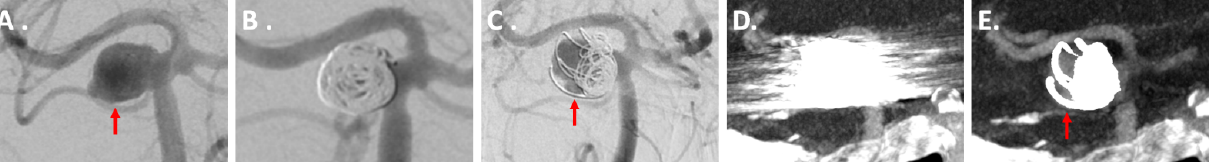
Figure 2. A 63-year-old patient with an aneurysm of the basilar artery in the initial DSA (( A ) red arrow) with consecutive treatment via endovascular coiling ( B ). Six months later, DSA control revealed a reperfusion in the aneurysm center (( C ) red arrow). The aneurysm was not assessable in iMAR − FD-CTA due to severe metal artifacts ( D ). After application of iMAR and the following significant metal artifact reduction, FD-CTA also demonstrated reperfusion in the aneurysm center (( E ) red arrow).